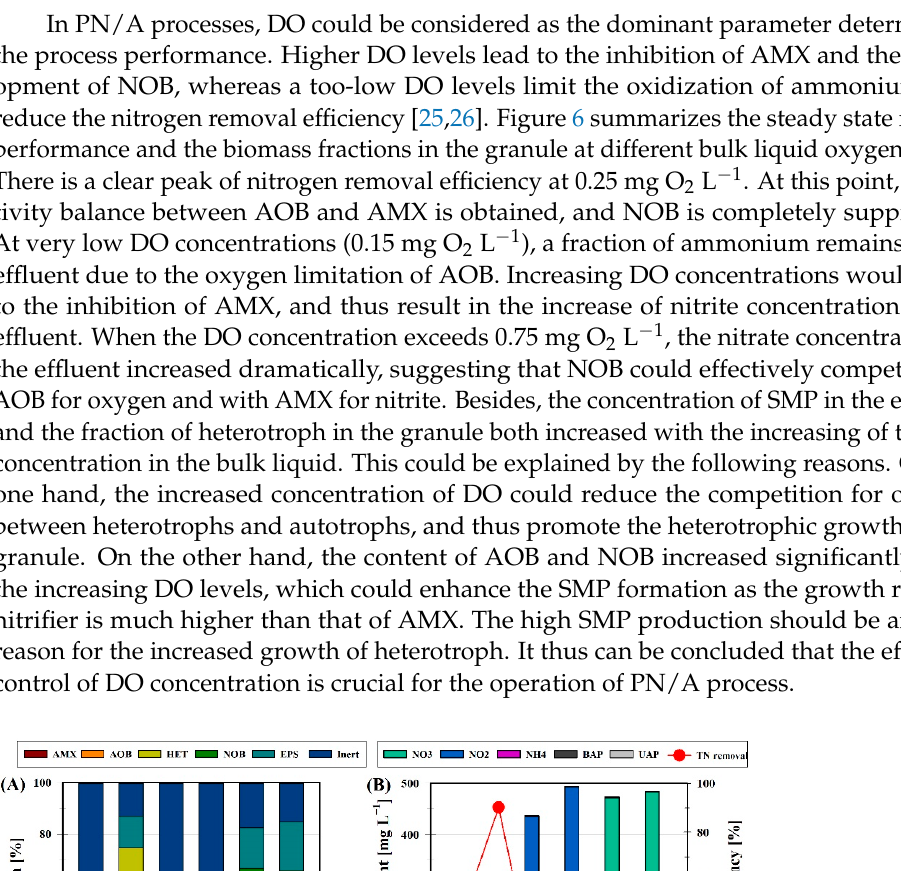
optimal DO concentration for maximum nitrogen removal efficiency at a certain granule size [27]. In order to evaluate the effect of the granule size on biomass fractions and nitro- gen removal, simulations were performed for a broad range of granule diameters. It should be pointed out that the total concentration of granules (VSS) in the reactor has been set constant at 4000 g COD m − 3 in these simulations, meaning that the number of granules was varied as the granule diameter. As shown in Figure 7, it can be observed that a high total nitrogen removal efficiency (>88%) could be achieved for all granule sizes ranging from 0.3 to 2.0 mm by controlling the bulk oxygen concentration within an optimal value. Moreover, as the granule diame- ter increases, higher bulk oxygen concentrations are needed to achieve maximum nitrogen removal. This can be attributed to the lower surface to volume ratio of spherical particles associated with larger granules, resulting in less aerobic and more anoxic volume. Figure 7. Mode-base analysis for the influence of granule size on heterotrophic growth in the gran- ules: ( A ) biomass fractions and ( B ) nitrogen removal. Note that simulations were performed under different granule diameters with corresponding optimal bulk oxygen concentrations. The fraction of AMX in the granule did not change significantly with increasing gran- ule size, whereas the fractions of AOB and HET decreased slightly (Figure 7A). This can be attributed to the increased oxygen concentration in the bulk liquid associated with larger granules, resulting in a higher activity for AOB and HET. However, little difference